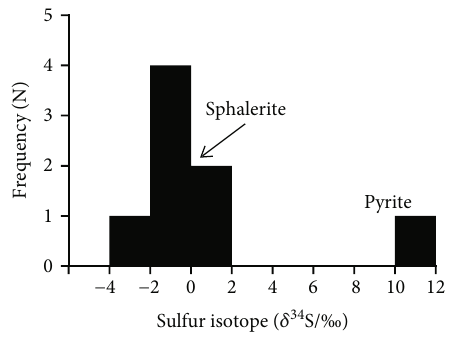
Figure 6: Histograms of the sulfur isotopic compositions of sul fi des from the Laoyingqing